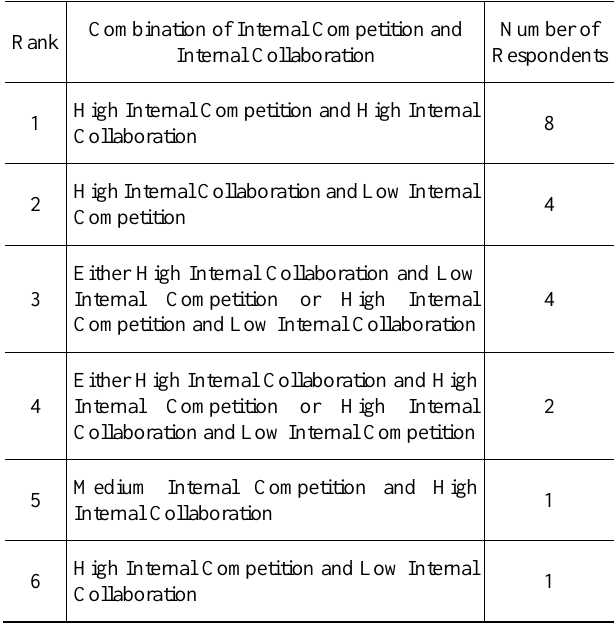
Table 8: Preferred combinations of internal competition and internal collaboration